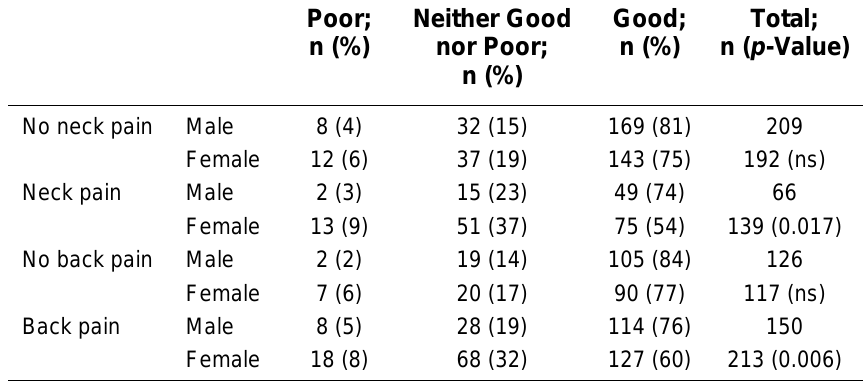
Self-Related Health and Its Relation to Appearance of Neck Pain and Back Pain (n = 606, 2 People Missing)